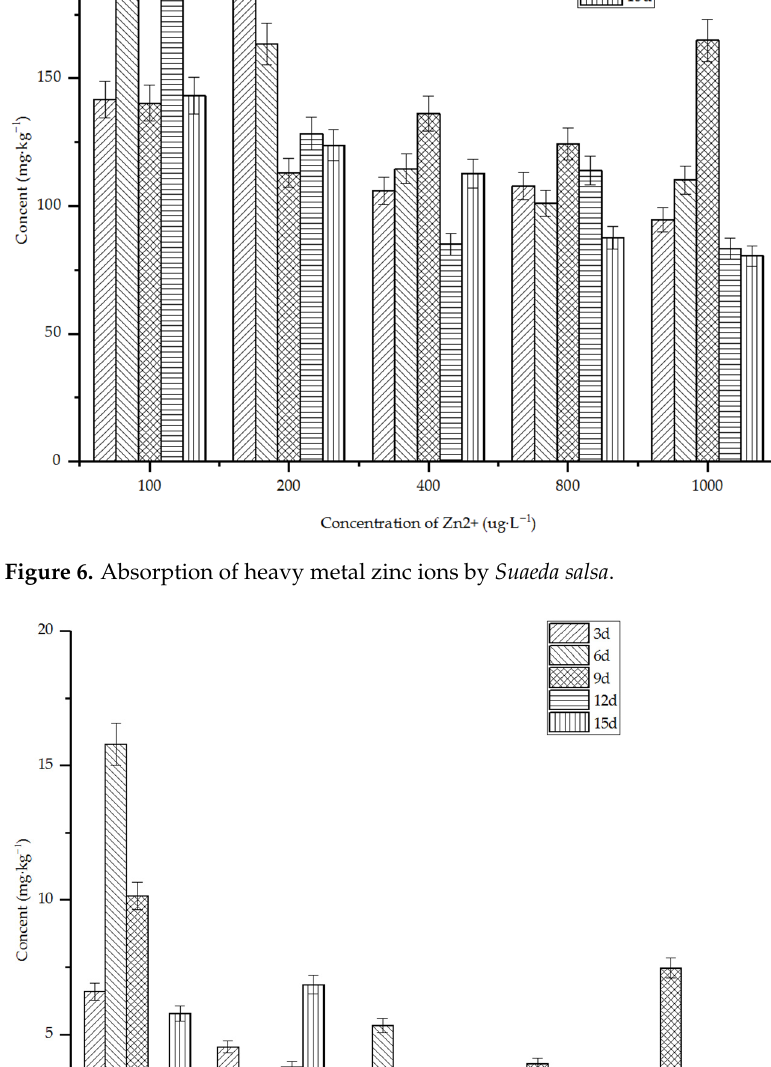
Figure 6. Absorption of heavy metal zinc ions by Suaeda salsa.